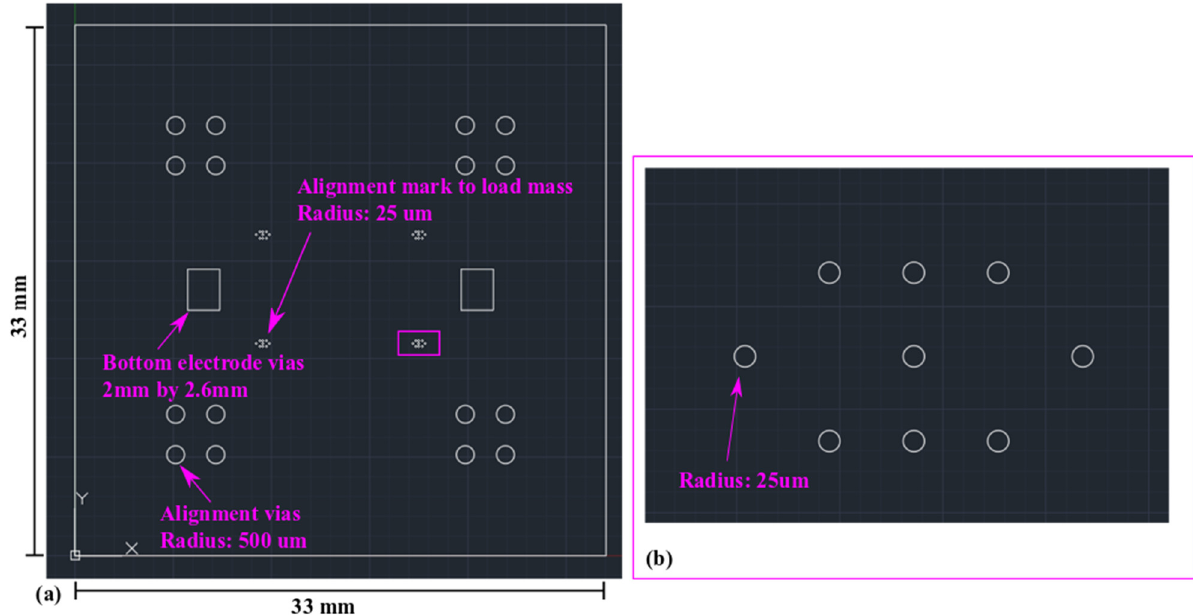
Figure 8. Mass sensor structural layer laser micromachining mask. ( a ) The overall view. ( b ) The zoom-in view of the mass-loading alignment markers.